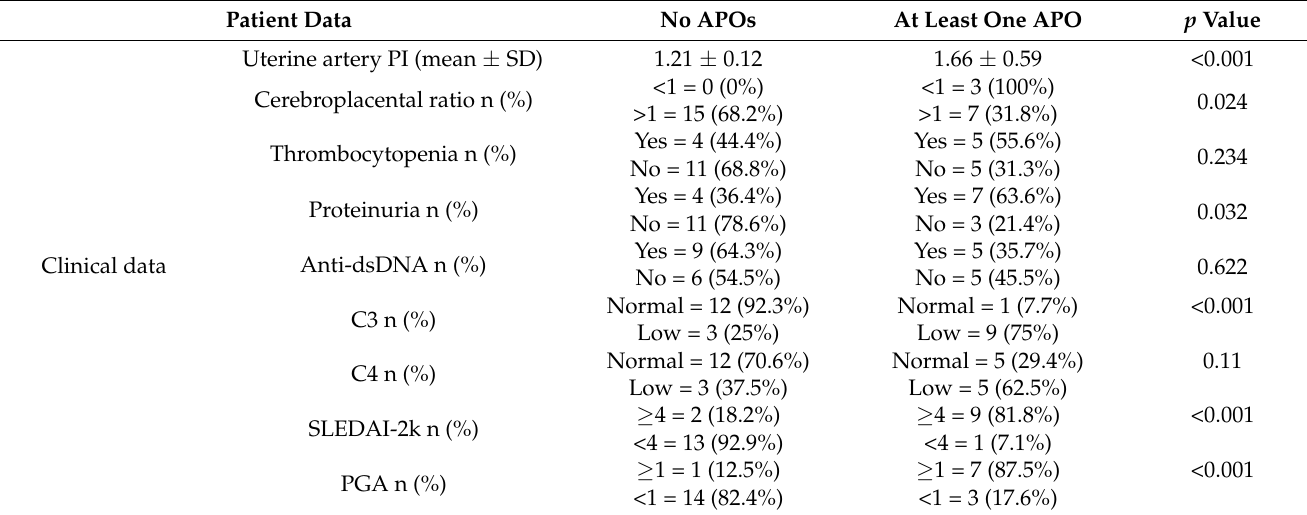
Table 2. Characteristics of pregnant SLE patients in the second trimester, and their association with adverse pregnancy outcomes